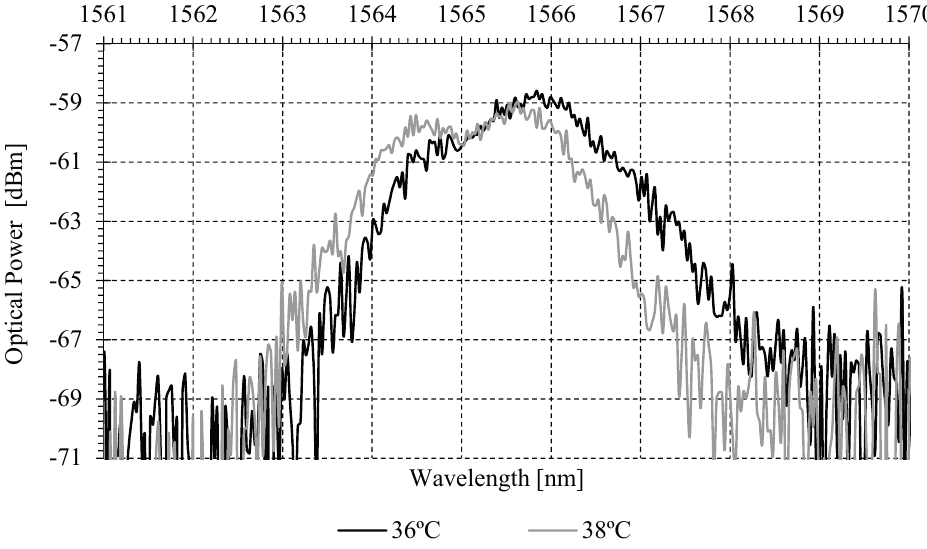
Figure 9. Optical spectrum in reflective operation for the mPOFBGs versus